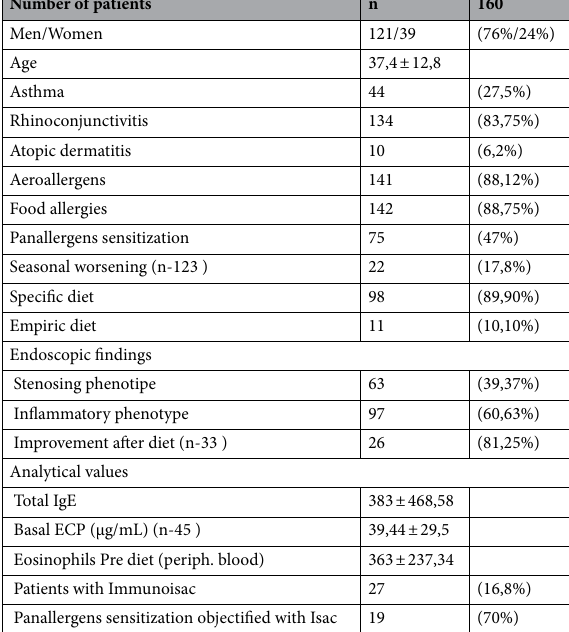
Table 1. Clinical and sociodemographic characteristics of the included